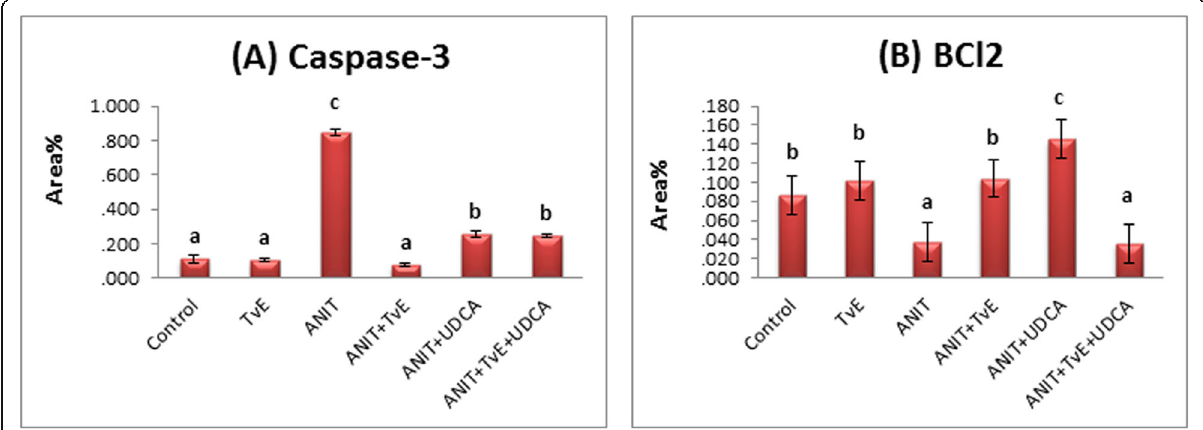
Fig. 6 Histogram of area % of ( a ) caspase-3 and ( b ) Bcl-2 protein in liver cells. Expression positivity of caspase-3 and Bcl-2 in hepatocytes of rats was presented as mean ± standard error of the mean (SEM). Values with different superscript letters are significantly different ( P <